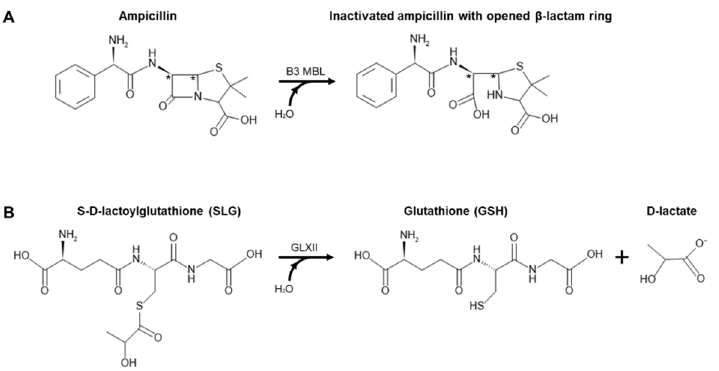
Figure 1. Reaction catalyzed by ( A ) B3 MBL [11] and ( B ) GLXII [13] drawn using MedChem Designer (version 5.5.0.11, Simulations Plus Inc., Lancaster, CA, USA).